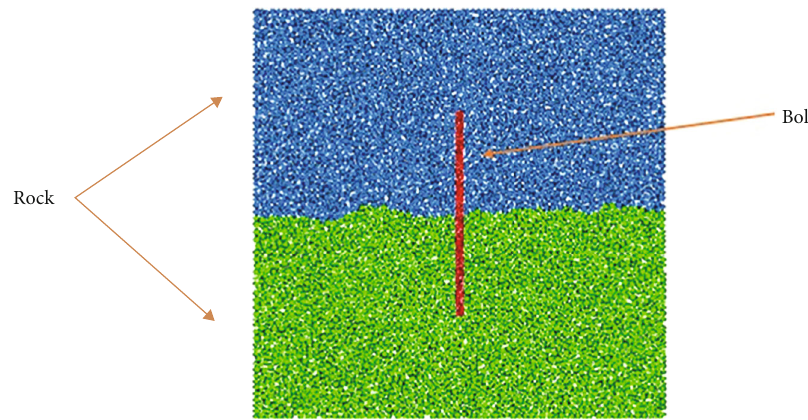
Figure 1: Numerical model of bolted joint subjected to rheological direct shear. Table 1: Mesoscopic parameters of the numerical